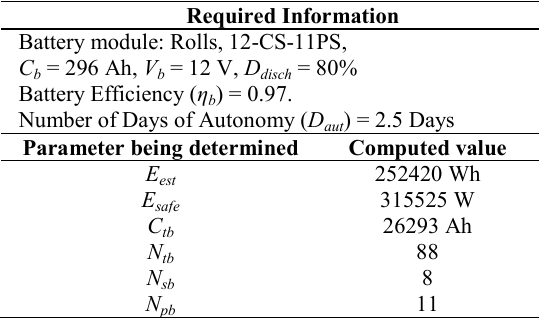
Table 6. Summary of battery bank